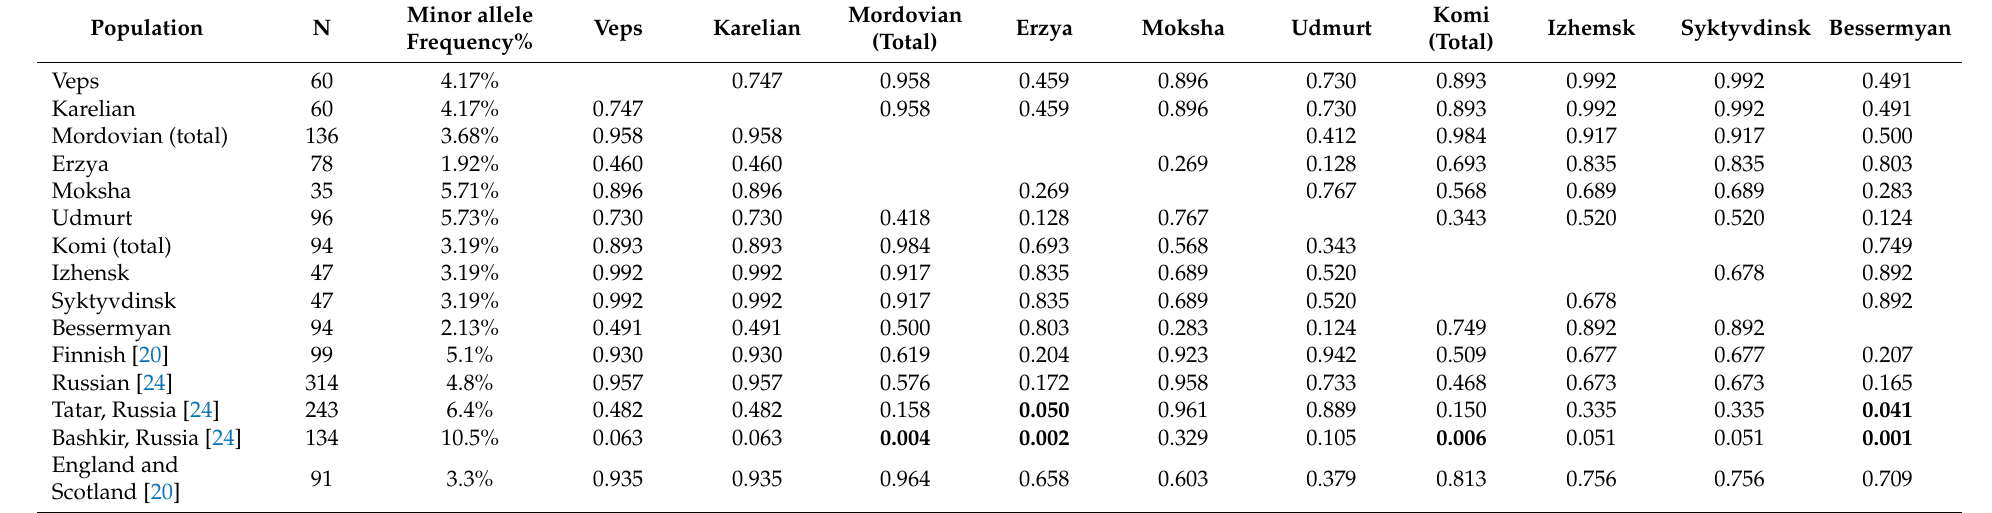
Table 3. Frequencies of the minor allele rs1048943 of the CYP1A1 gene in the studied samples of Finno-Permic peoples, as well as in some populations of the